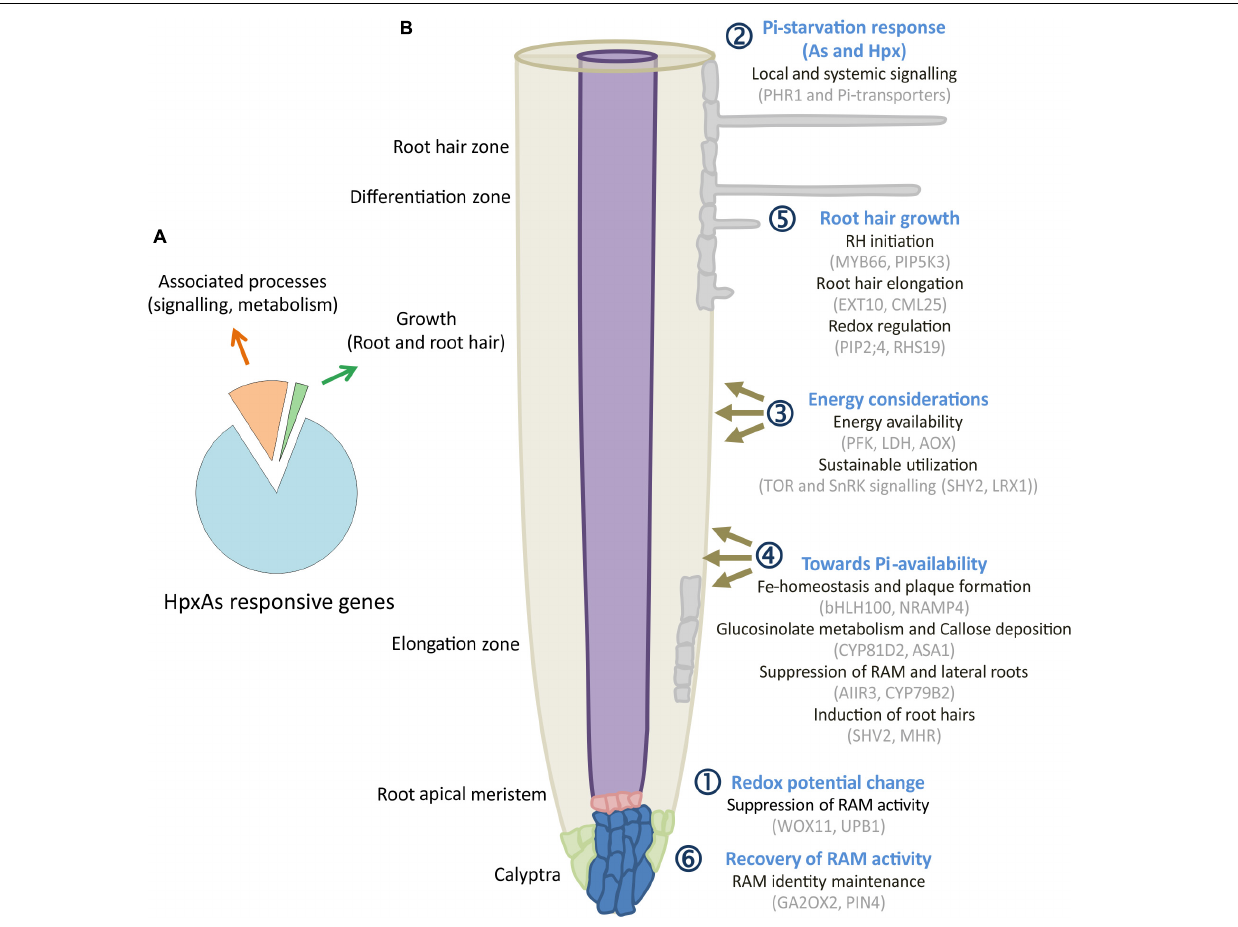
FIGURE 8 | HpxAs-specific changes in root development pattern. (A) Pie chart gives distribution of genes identified for their involvement in root and RH development among all the genes with unique transcript deregulation under HpxAs. (B) The schematic shows a spatiotemporal arrangement of contemplated events in roots under HpxAs exposure. Events are categorized into six groups with emphasis on role of phosphate homeostasis deregulation and associated redox, low energy state-dependent signaling events. Further studies should be focused on the specific analysis of these described transcripts in order to decipher their particular role in HpxAs-stress acclimation as well as to resolve the temporal information that could lead to better mechanistic understanding. See text for detailed discussion of the processes depicted in this figure.